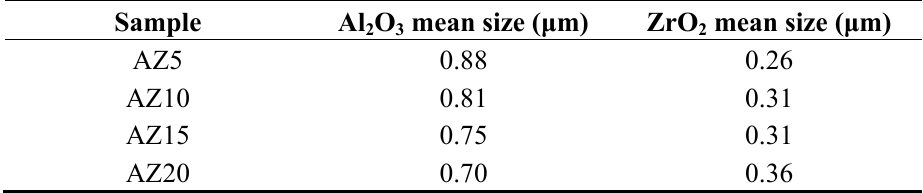
Table 2. Alumina and zirconia mean grain size, as obtained by image